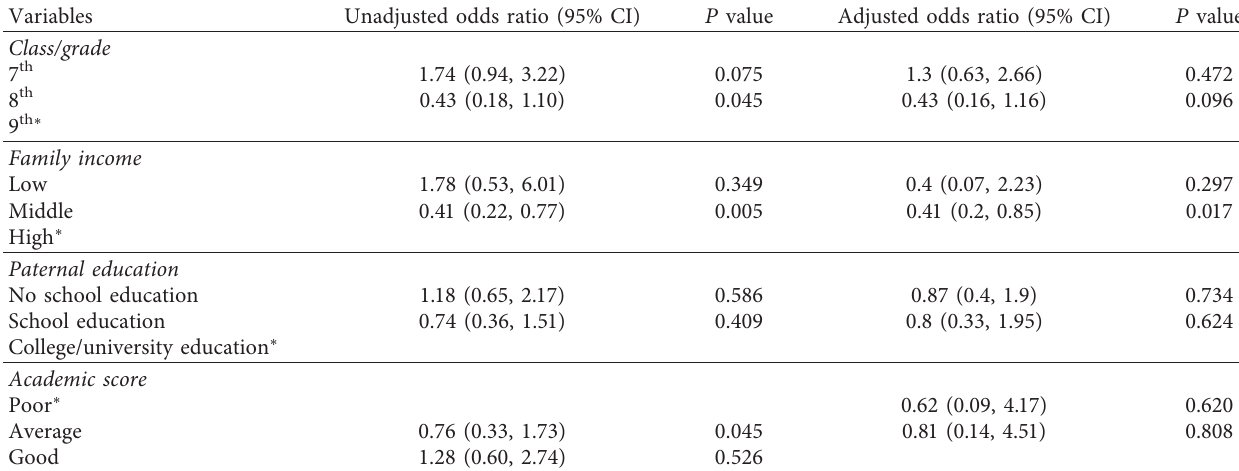
Table 3: Association between sociodemographic factors and receipt of treatment for dental